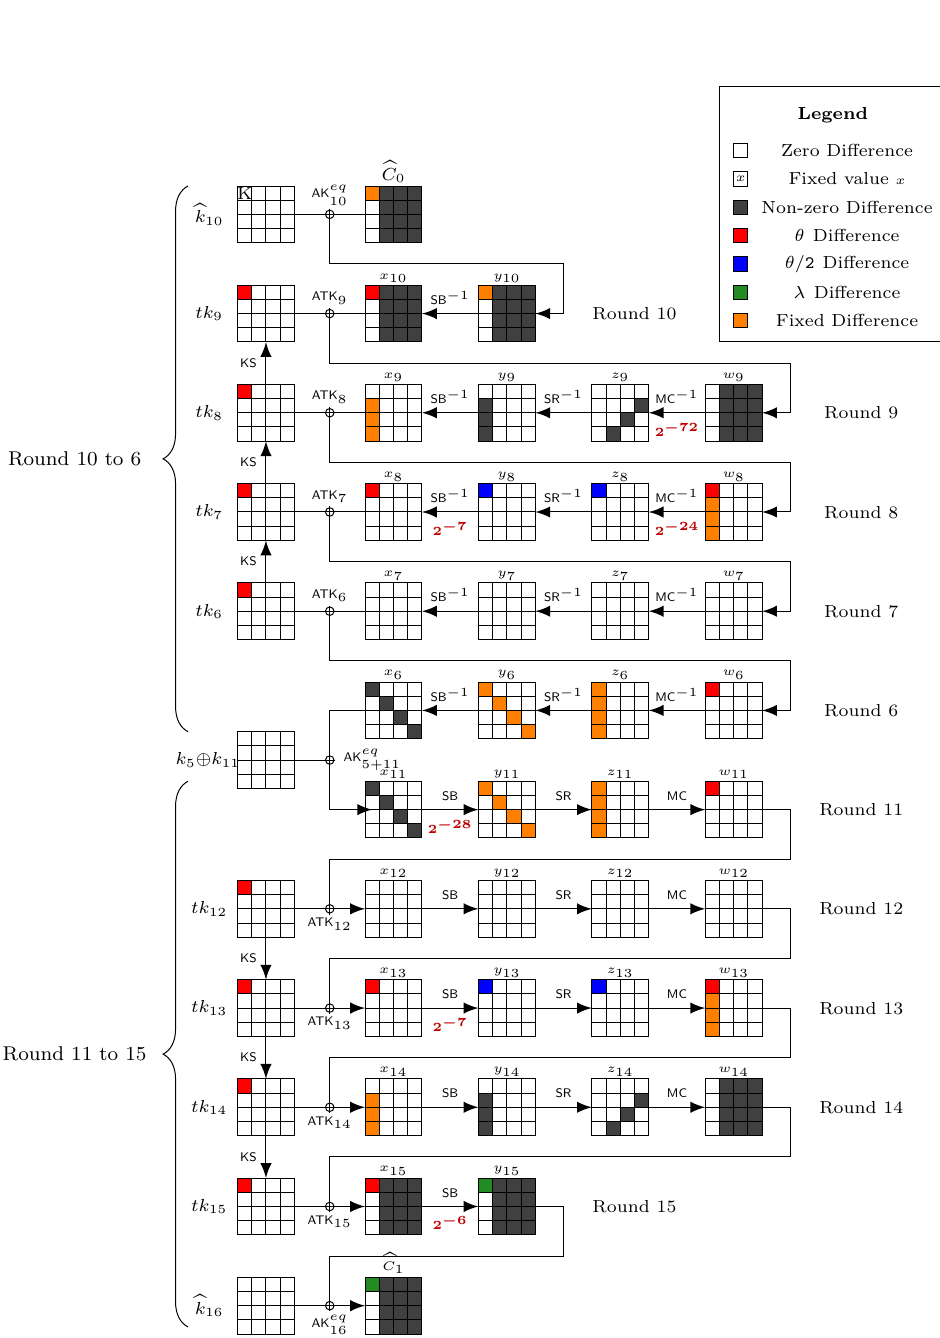
Figure 11: Differential characteristic for 2 124 weak